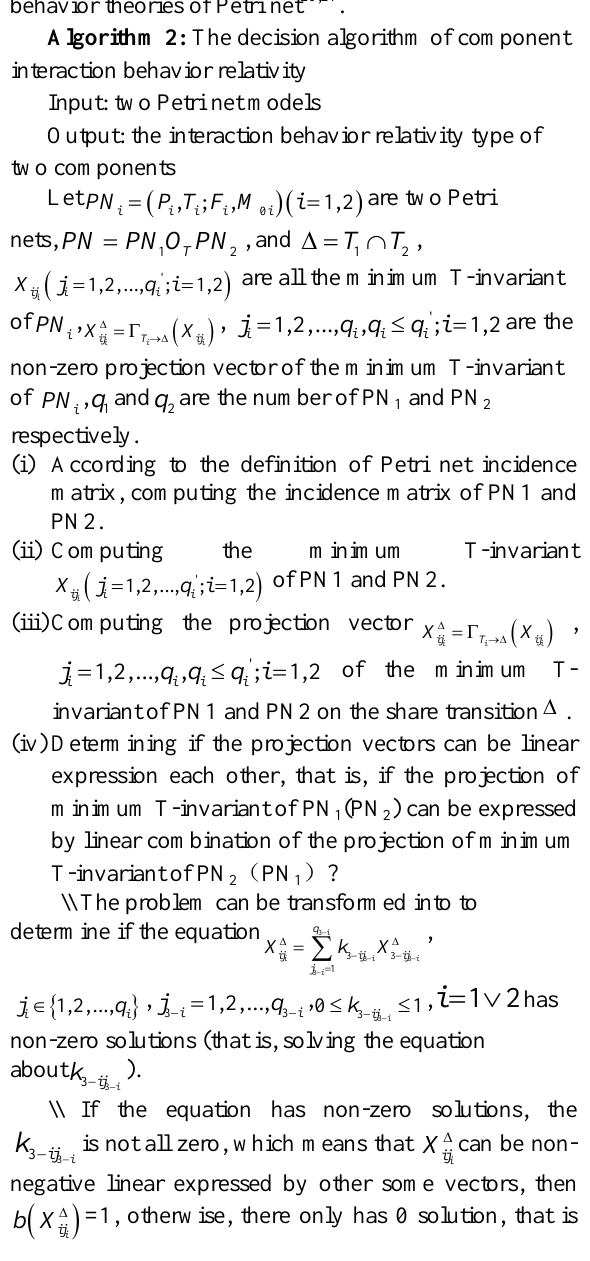
Algorithm 2: The decision algorithm of component interaction behavior